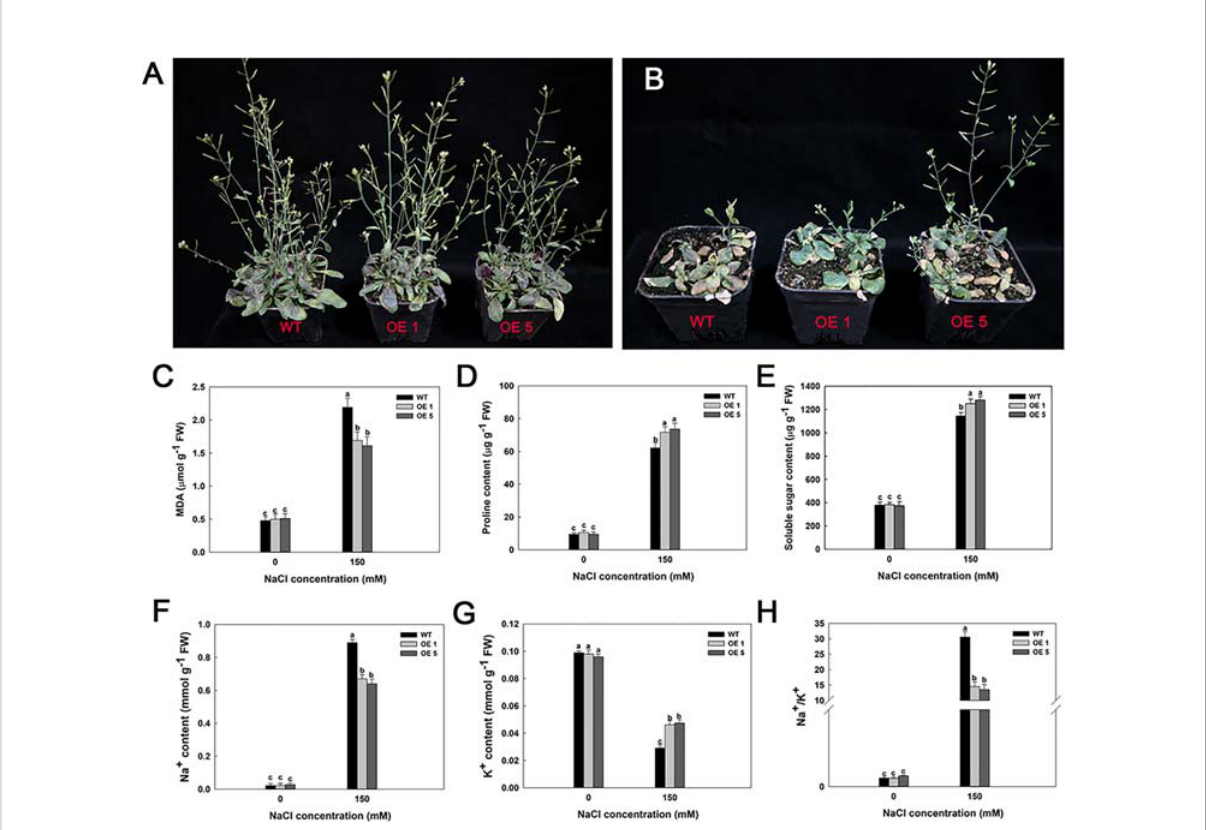
FIGURE 7 Phenotypes and physiological indexes of LbMYB48 over-expression lines and wild-type lines at maturity stage under 0 and 150 mM NaCl. (A) Different genotypes under normal growth condition; (B) Different genotypes under 150 mM NaCl for 14 d; (C) MDA content; (D) Proline content; (E) Soluble sugar content; (F) Na+ content; (G) K+ content; (H) Ratio of Na+ content to K+ content. Three replicates were used to calculate the standard deviation (SD) and ensure accuracy. Different letters (a – c) were used to indicate signi fi cant differences between different columns at P <